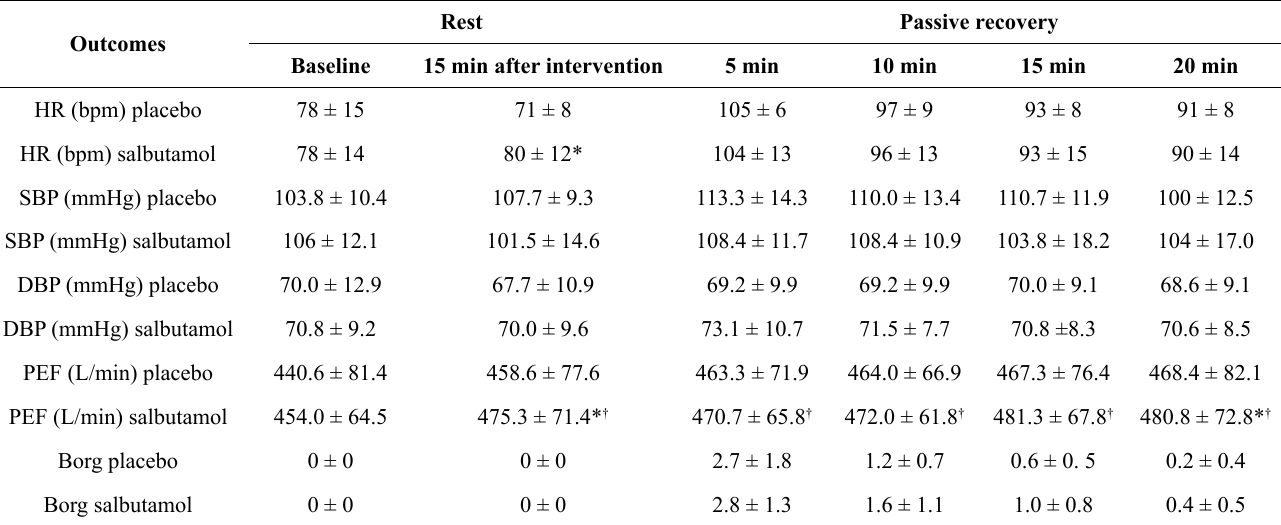
Table 2 : Resting data at 10 min before (baseline) and 15 min after placebo and salbutamol interventions, and passive recovery phase at 5, 10, 15, and 20 min after the maximal stress test.